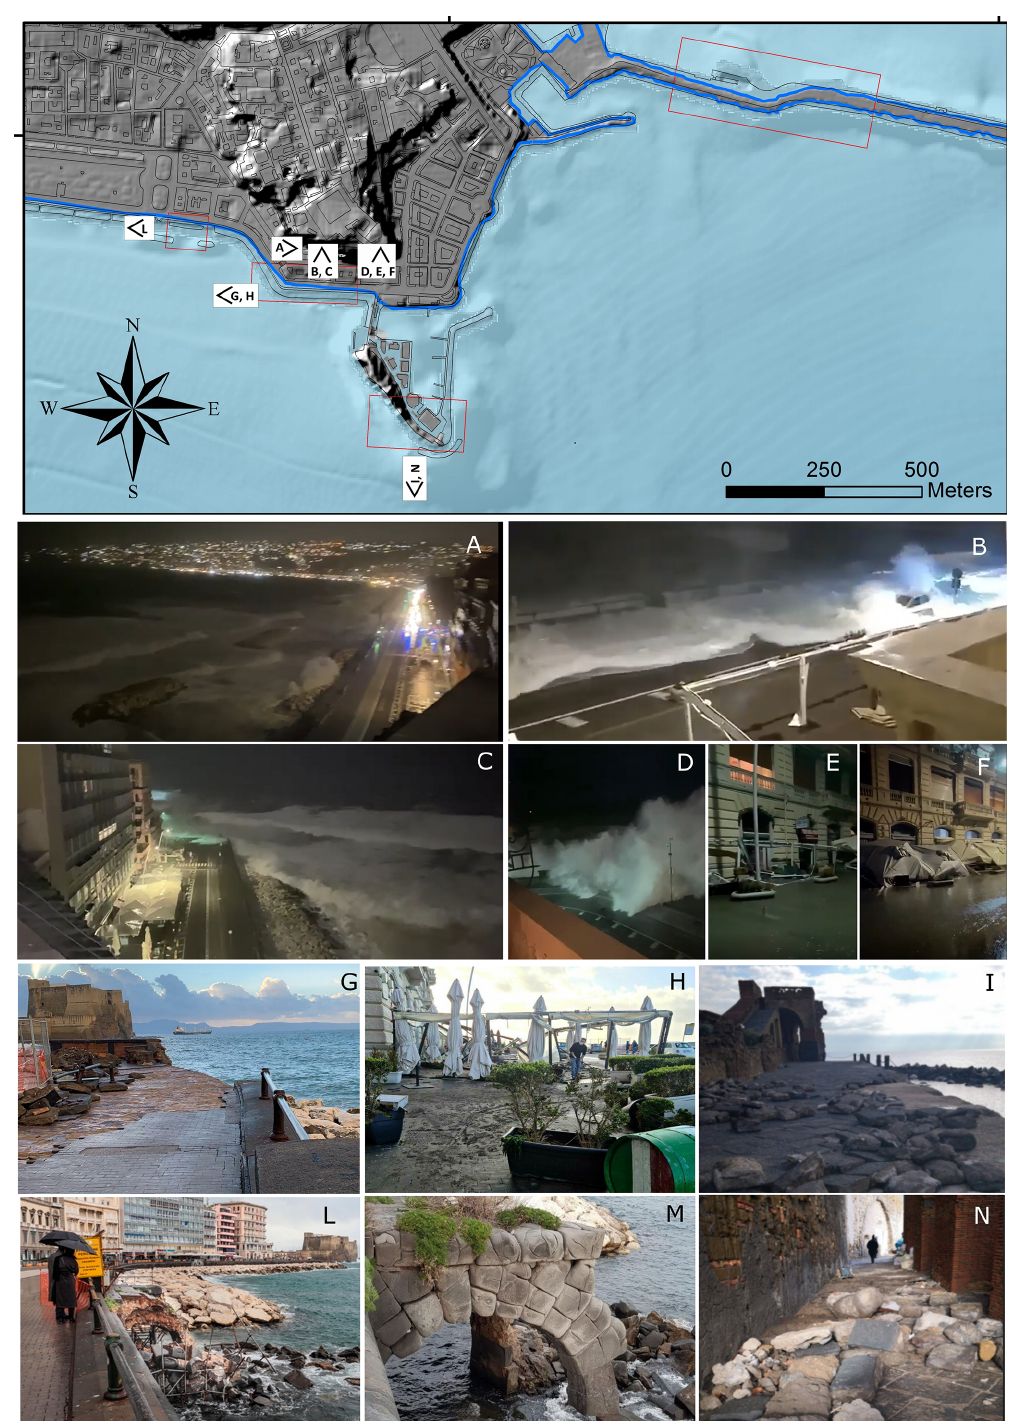
Figure 12. (a–d) Photos of storm surge in the coastal area with maximum setup values (Naples city center), (e, f) damages to structures during the event, (g) promenade destroyed with collapsed parapet, (h) shattered shop windows, (i, n) Castel dell’Ovo after the event, (l, m) Bourbon pier after the event, (h) Bourbon pier before the event. On the map, the onshore DTM from lidar data was provided by the Ministero dell’Ambiente; the offshore DTM was derived from bathymetric data provided by Regione Campania.